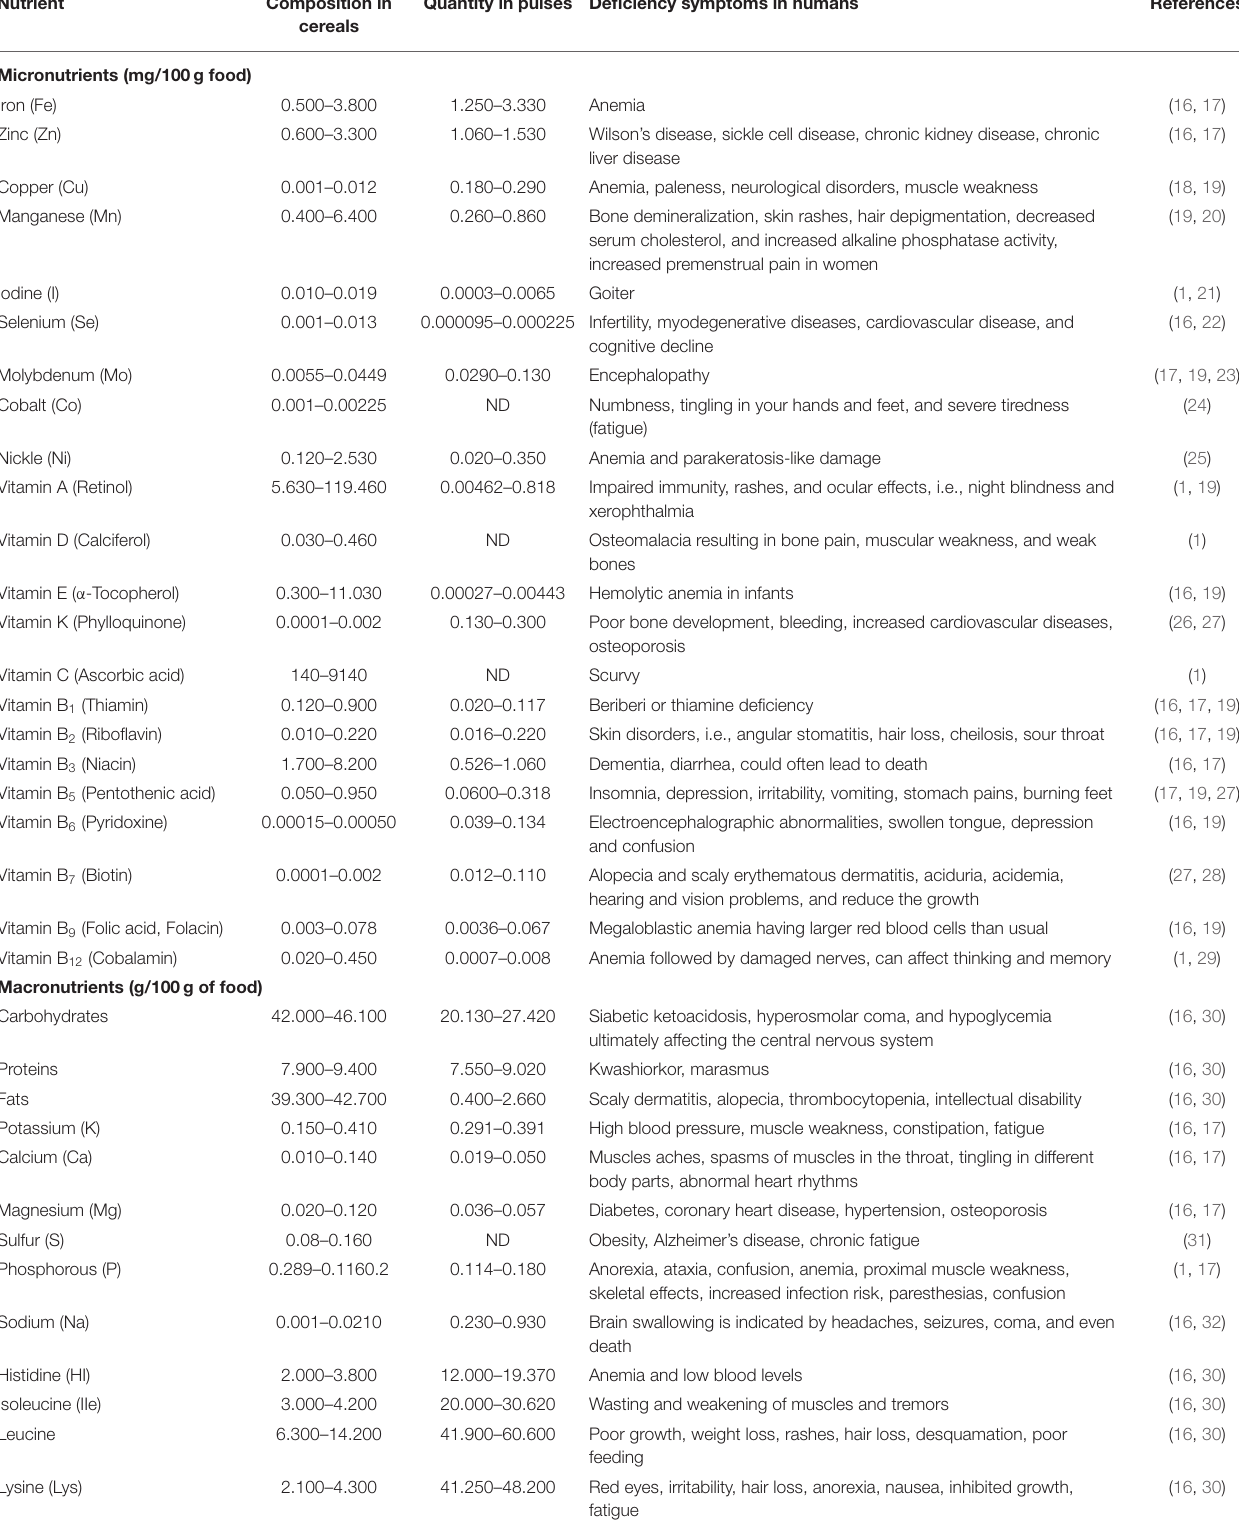
TABLE 1 | Essential micro- and macro-nutrients required for good human